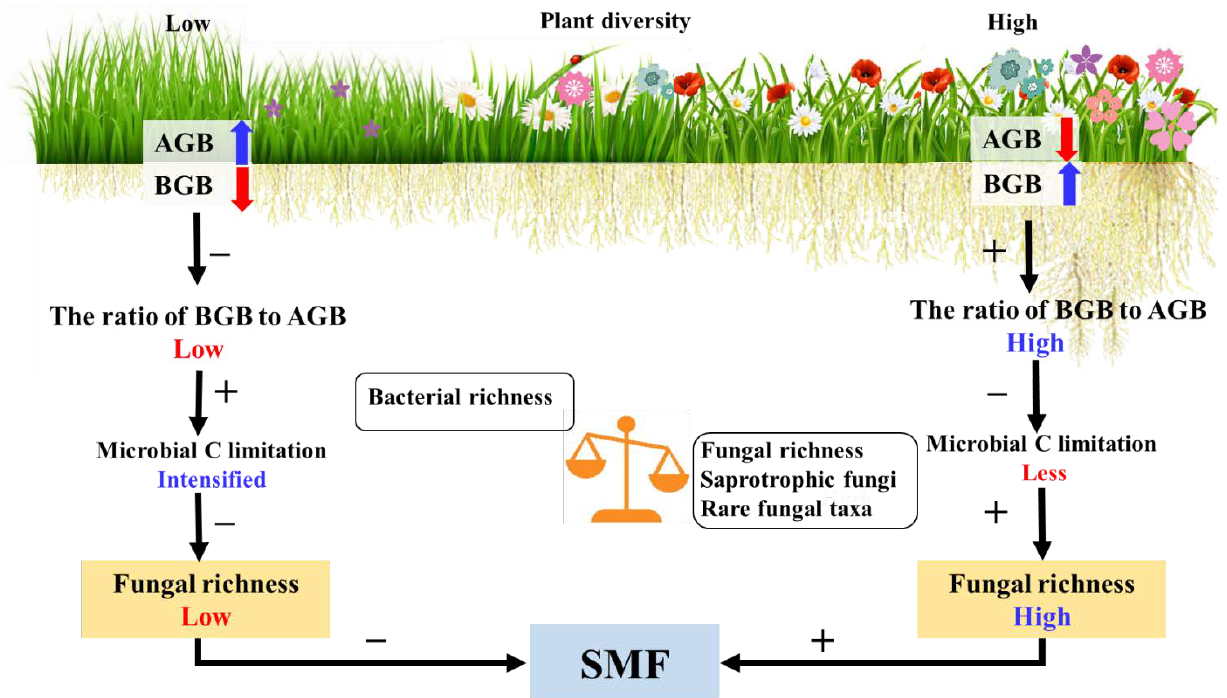
Figure 9. A conceptual framework for understanding the effects of plant and fungal richness on soil multifunctionality in a semi-arid grassland. Changing plant biomass allocation patterns increased the ratio of plant below-ground biomass to above-ground biomass under high diversity plant assemblages, which can alleviate microbial carbon (C) limitation and thus enhance the fungal richness, finally promoting soil multifunctionality. The fungal richness was positively related to soil multifunctionality, but the bacterial richness was not. Saprotrophic fungi and rare fungal taxa were essential for maintaining the soil functions. The blue arrow represents an increase, and the red arrow represents a decrease. + and − describe promotion and inhibition effects. AGB: plant above-ground biomass; BGB: plant below-ground biomass; SMF: soil